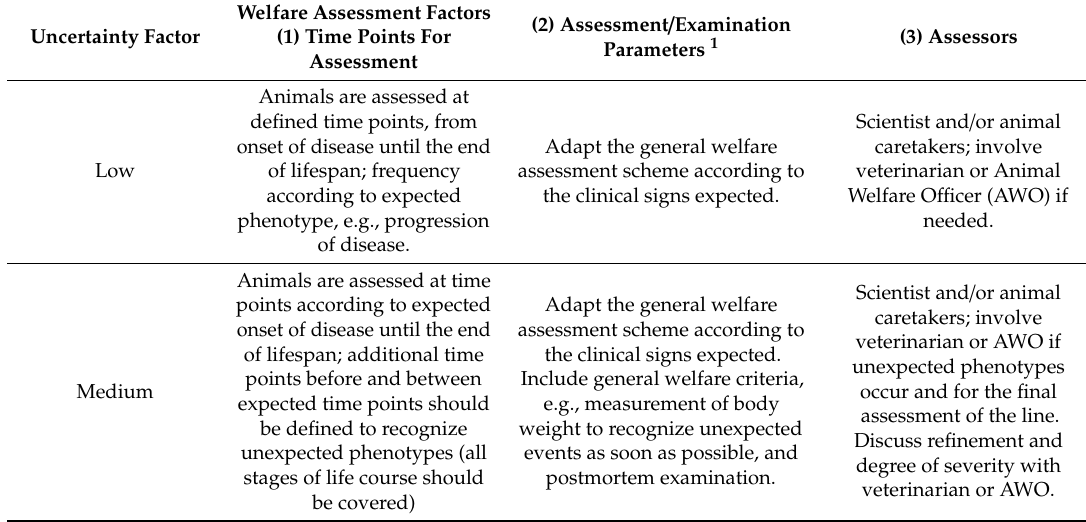
Table 2. Consequences of uncertainty: How to plan a structured welfare assessment and appropriate monitoring. appropriate